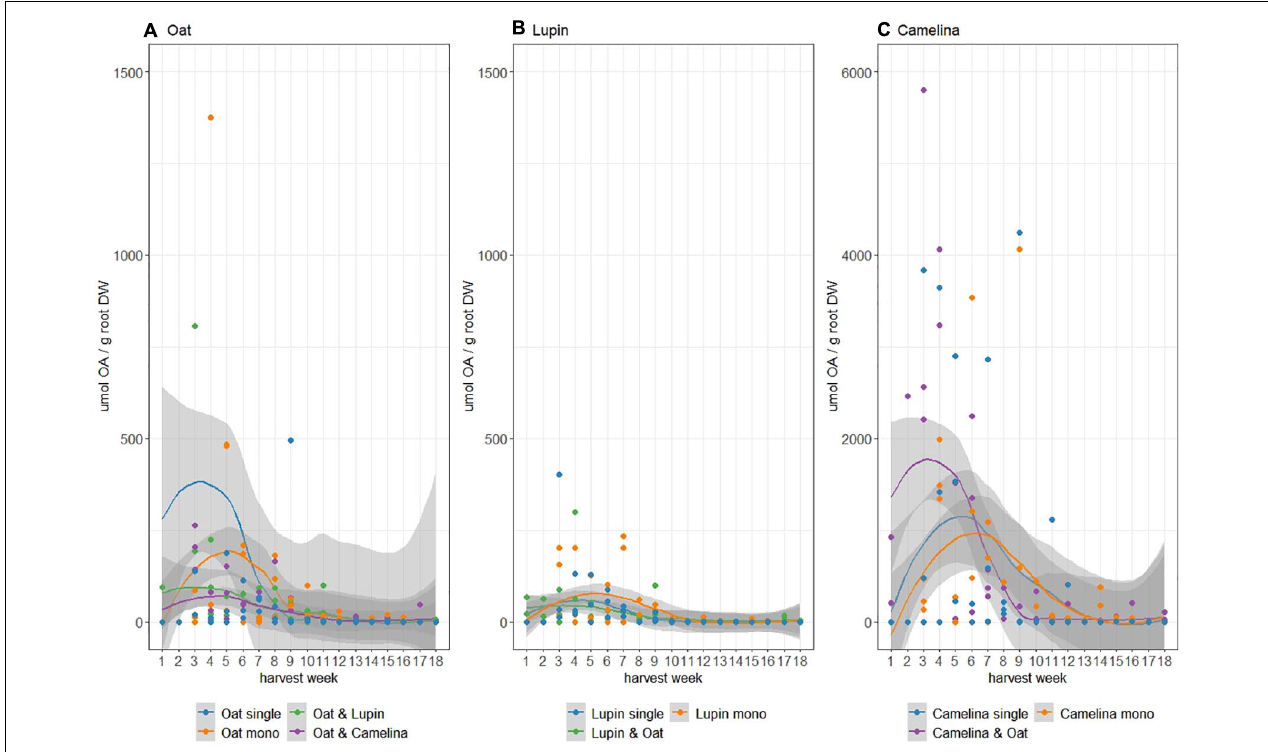
FIGURE 3 | Total organic acids (OA) found in rhizosphere soil in µ mol/g root dry weight of oat (A) , lupin (B) , and camelina (C) grown as isolated single plants (blue), monocultures (orange), and mixtures (green/purple). Note differing y -axis scales. Shading refers to standard errors computed using a t-based approximation.